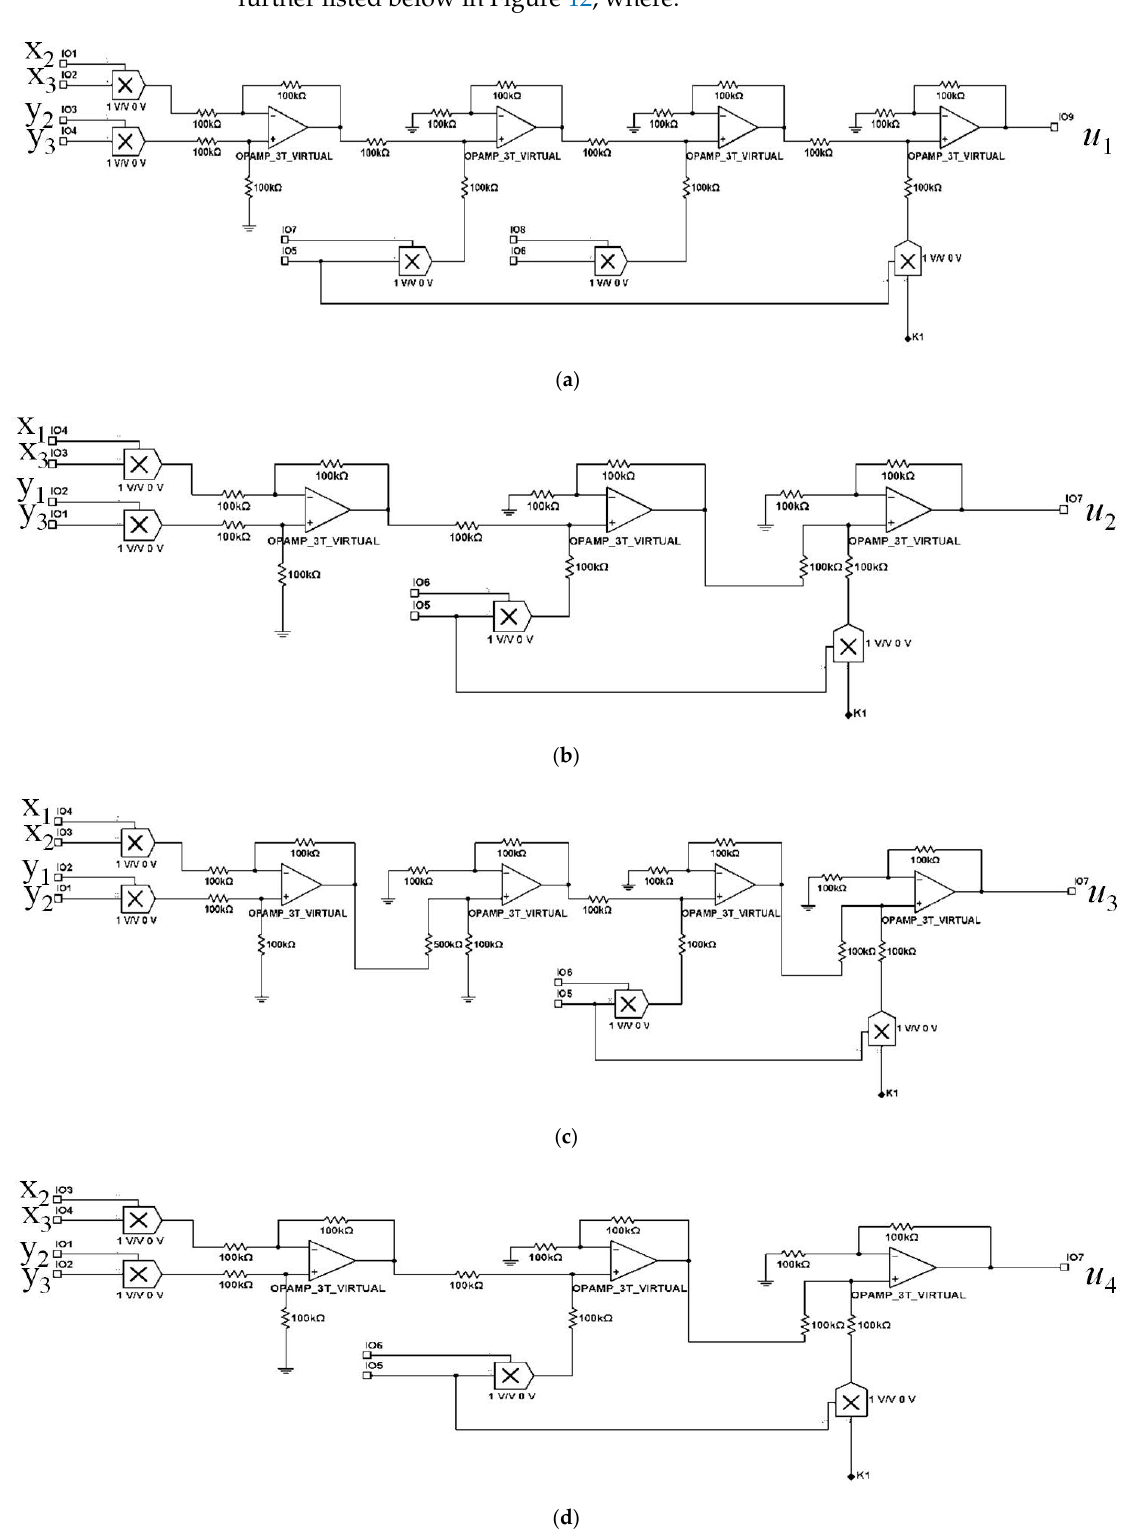
Figure 12. Circuit configuration of the controllers u 1 , u 2 , u 3 , and u 4 : ( a ) controller u 1 ; ( b ) controller u 2 ; ( c ) controller u 3 ; ( d ) controller u 4 .